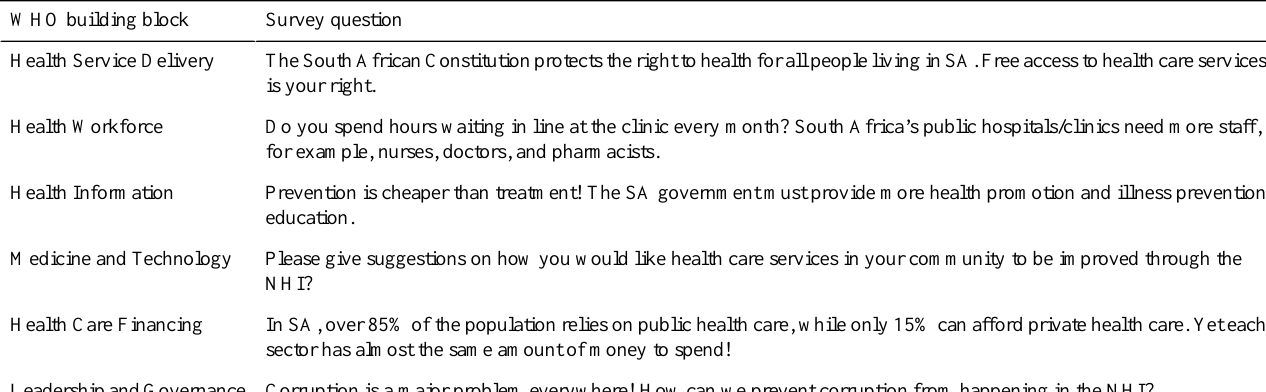
Table 1. Overview of the questions and statements addressing the South African health care consumers in the survey. Survey questionWHO building block